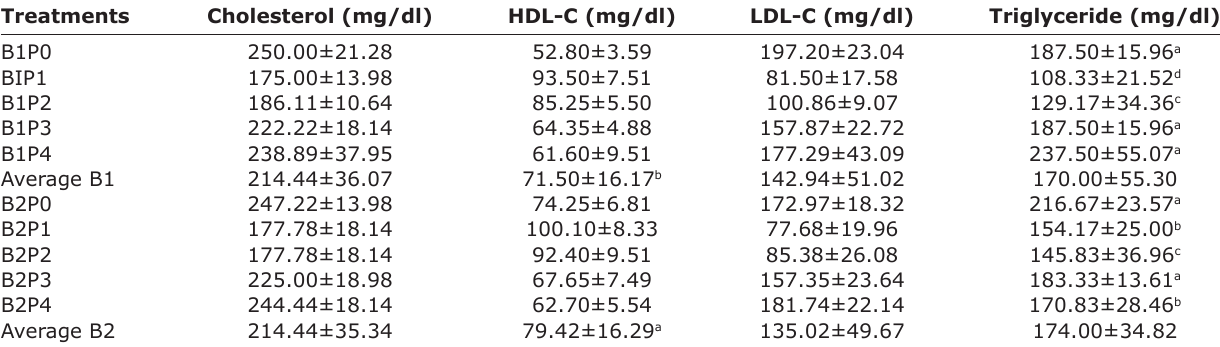
Table-2: Effect of interaction between breeds and phytogenics supplement on blood lipid profile. Treatments